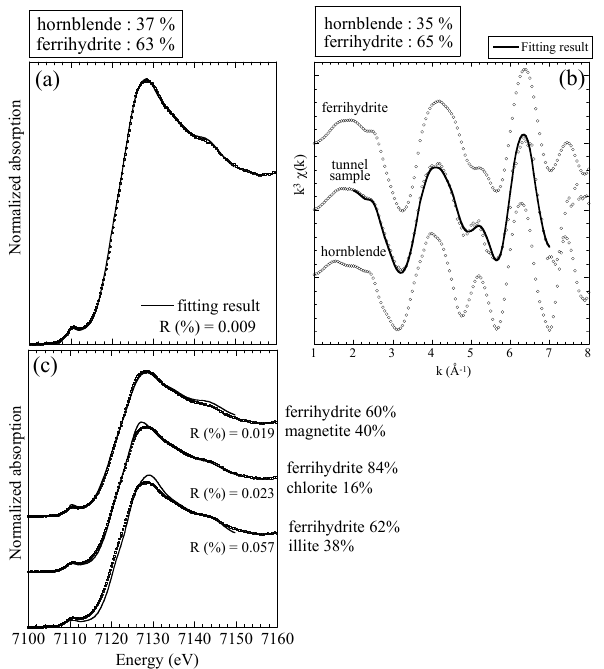
Fig. 9. (a) Iron K-edge XANES and (b) EXAFS for the sample collected in Yasumiyama Tunnel fitted by the spectra of hornblende and ferrihydrite. Examples of fitting by other Fe species are shown in (c) .